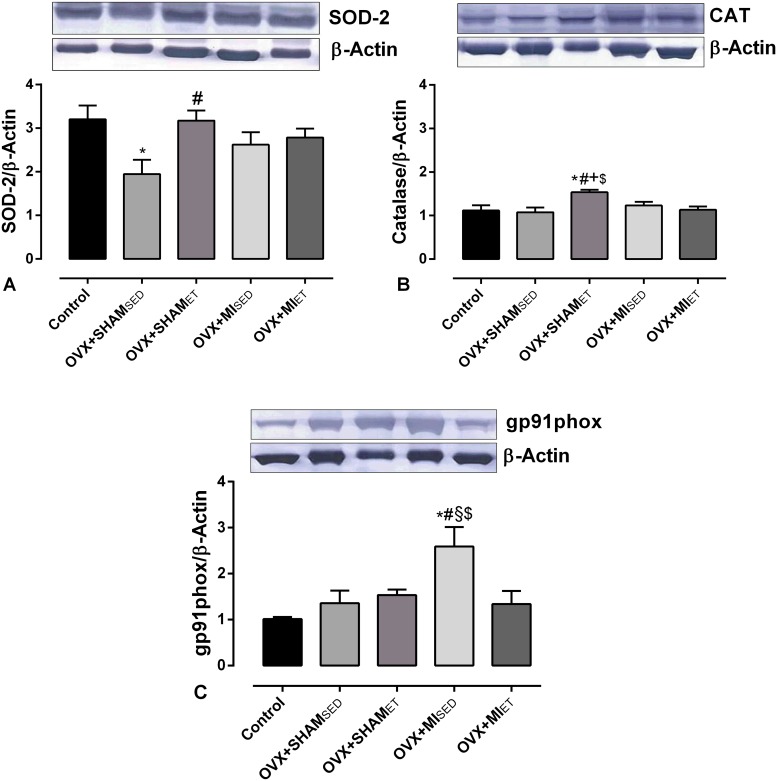
Protein expression of the enzymes SOD-2, Catalase, and gp91phox.Data are expressed as mean ± standard error of the mean (SEM). One-way ANOVA followed by the Fisher post-hoc test for multiple comparisons. *p <0.05 vs Control; #p <0.05 vs OVX+SHAMSED; §p <0.05 vs OVX+SHAMET; +p <0.05 vs OVX+MISED; $p <0.05 vs OVX+MIET.